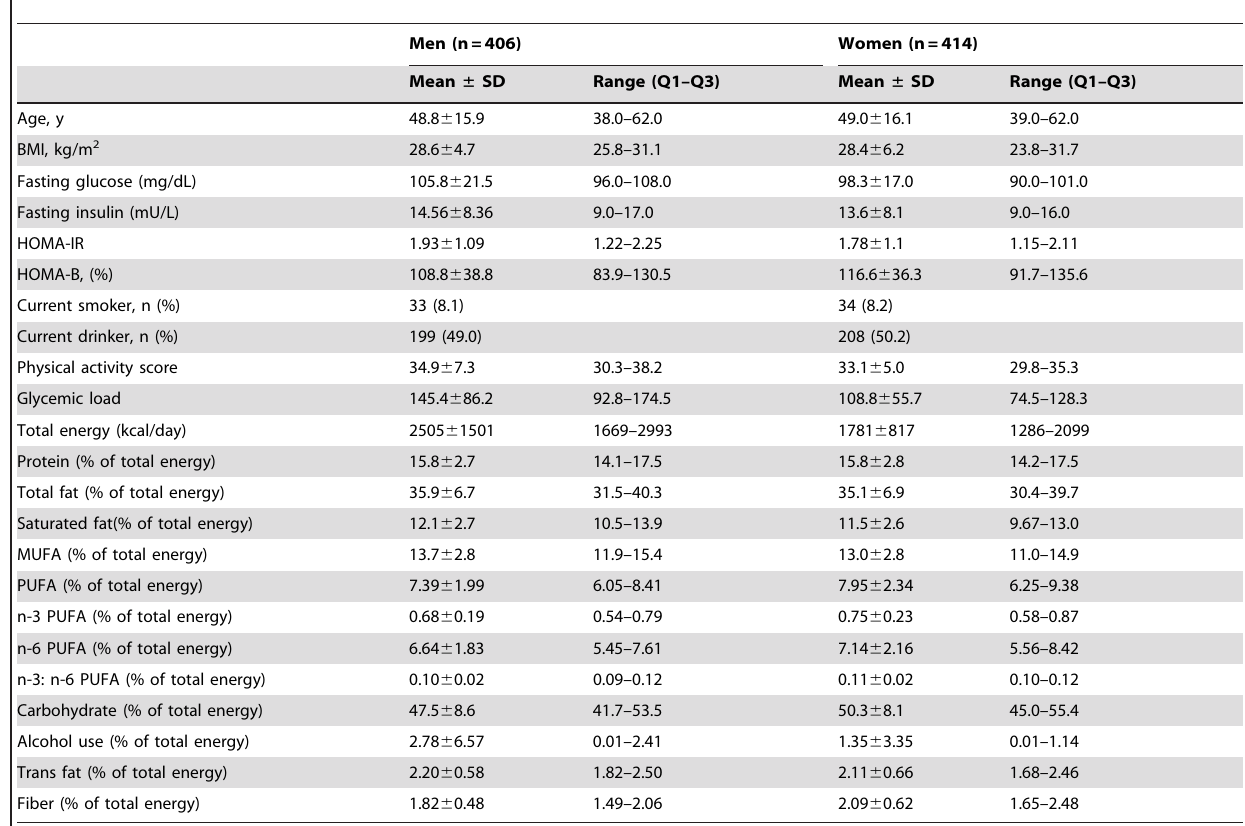
Table 1. Demographic and biochemical characteristics and dietary and lifestyle data in the GOLDN population 1